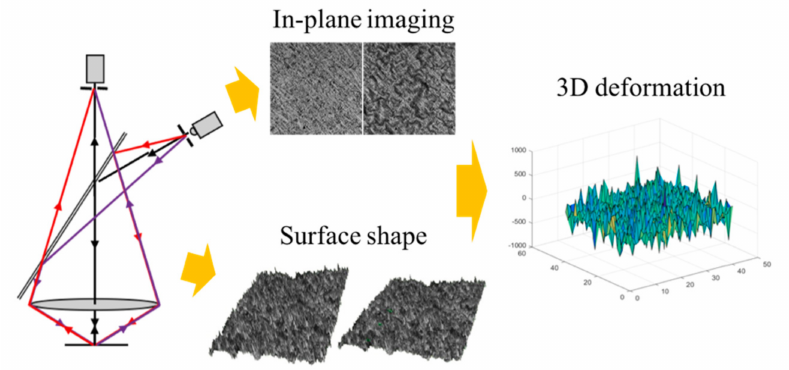
Figure 1. Imaging principles of the LCSM for in-plane images and surface